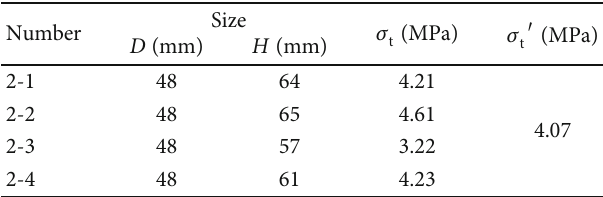
Table 4: Rock tensile test